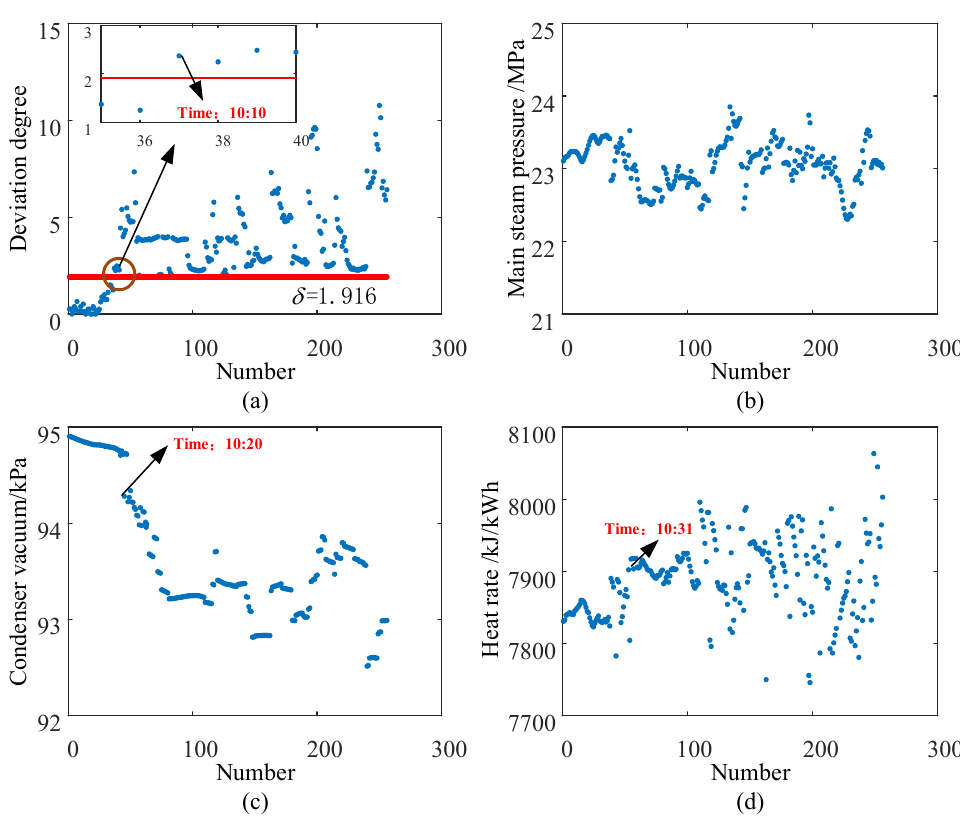
Figure 12. ( a ) Deviation degree values in time series. ( b ) Main steam pressure variation in time series. ( c ) Condenser vacuum variation in time series. ( d ) Heat rate variation in time series.